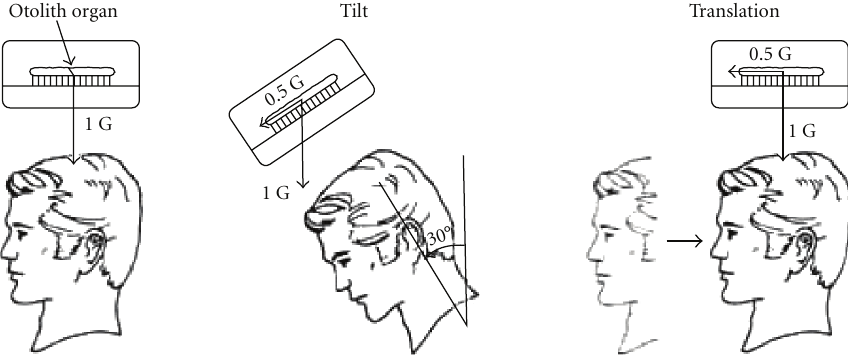
Figure 3: Mechanism of the otolith organs, showing their sensitivity to linear acceleration and head tilt. These drawings illustrate the shearing force in the plane of the utricular otolith membranes. For instance, a 30-degreeshead-tilt elicits a force equivalent to 0.5G in the plane of the utricular macula. The same stimulus can be achieved using a linear acceleration of 0.5 G with the head upright.